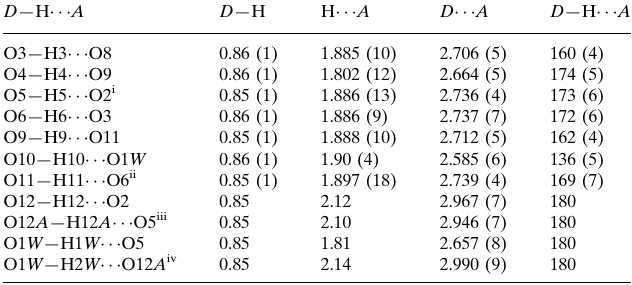
Hydrogen-bond geometry (A˚ , (cid:2)